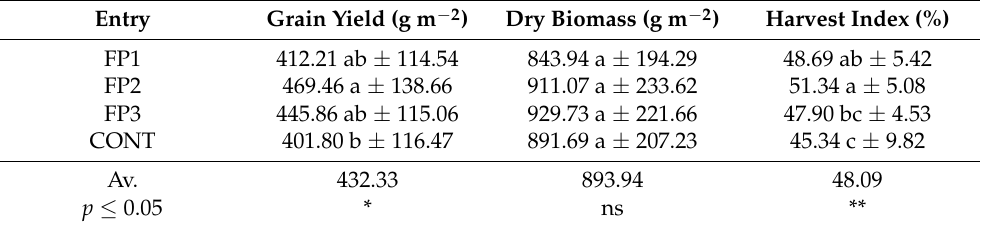
Table 6. Grain yield, dry biomass weight, and harvest index percentage of rice plants treated with different combinations of chemical fertilizer and plant-growth-promoting rhizobacteria.